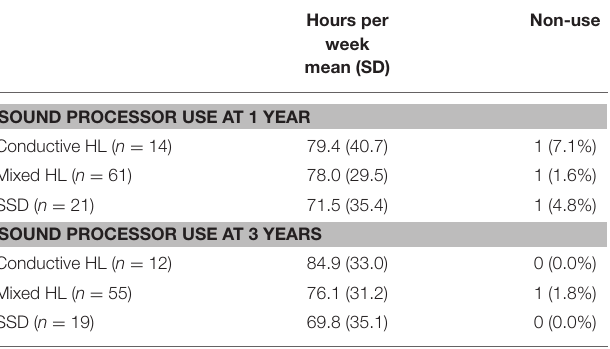
TABLE 8 | The sound processor use at 1 and 3 years is tabulated for the different